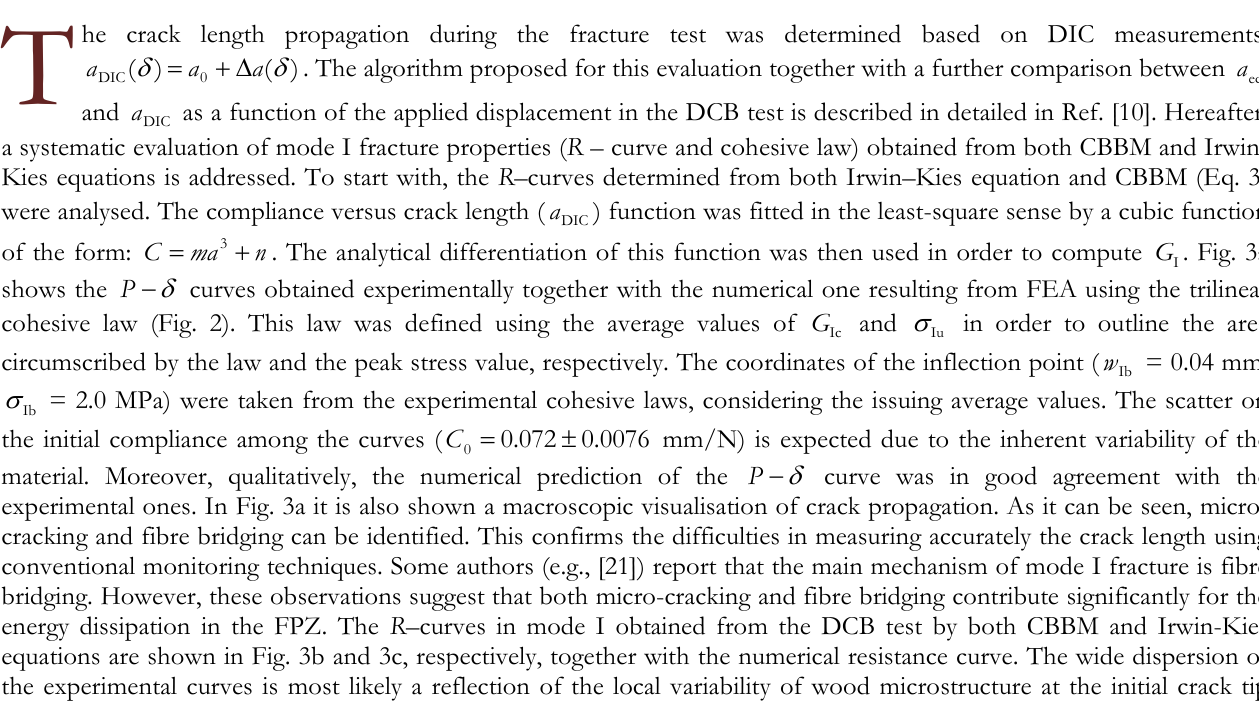
Table 2: Density (  ), flexural modulus ( DCB tests by CBBM and Irwin-Kies (IK)